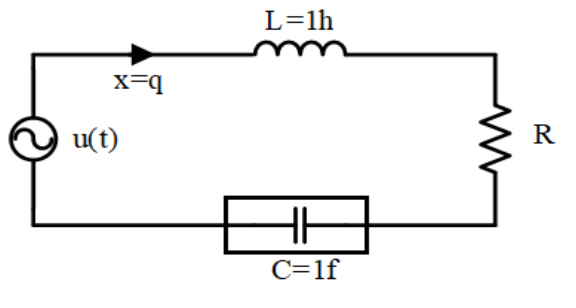
Figure 5. LRC circuit with nonlin- ear capacitive